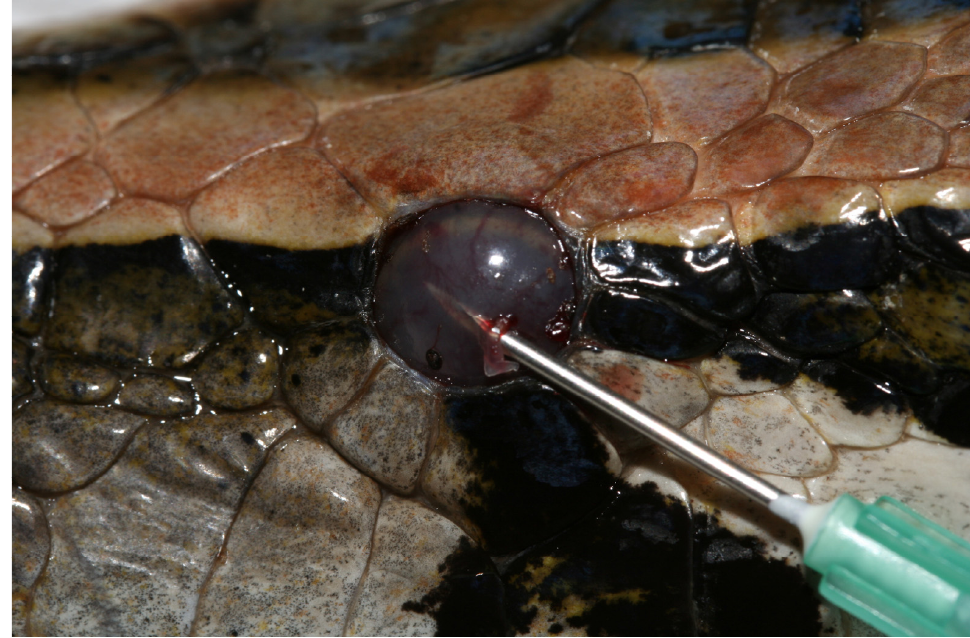
Figure 38. Insertion of a 21-gauge needle into a Burmese python ( Python bivittatus ) through the spectacle may allow aspiration of exudate from the subspectacular space and is also used as a first step in performing a partial spectaculectomy.